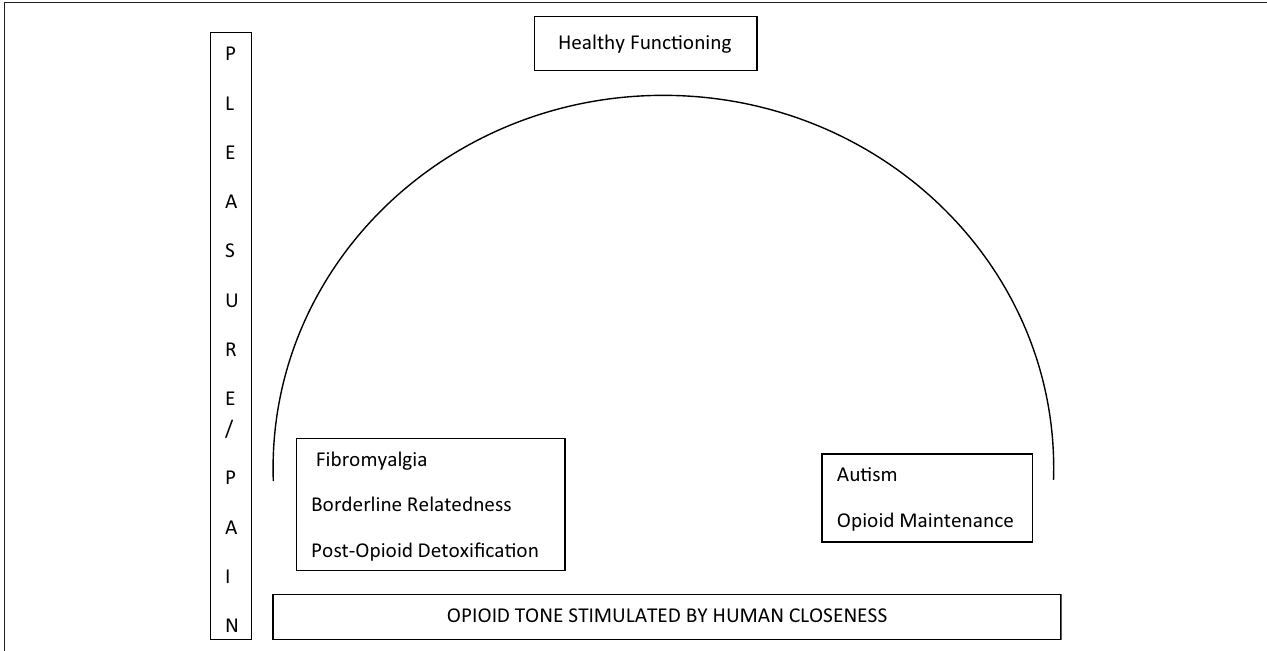
FIGURE 1 | Relationship of pleasure and opioid tone in the central nervous system subcortical